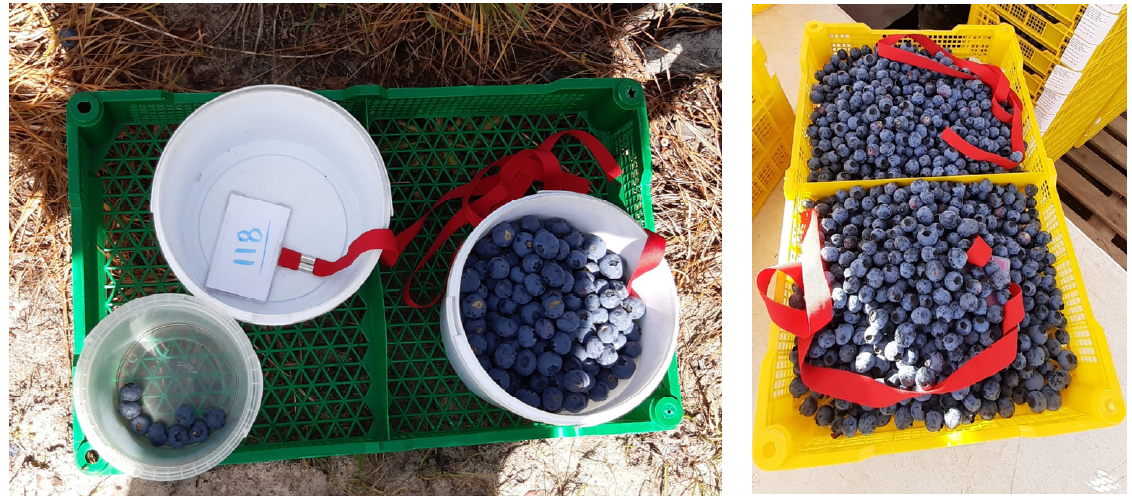
Figure 3. iButtons ® in one-litre buckets during harvesting and in crates at QC station . Source: [13].